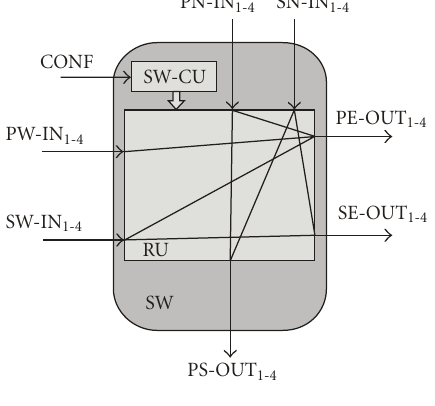
Figure 16: Block diagram of the SW.